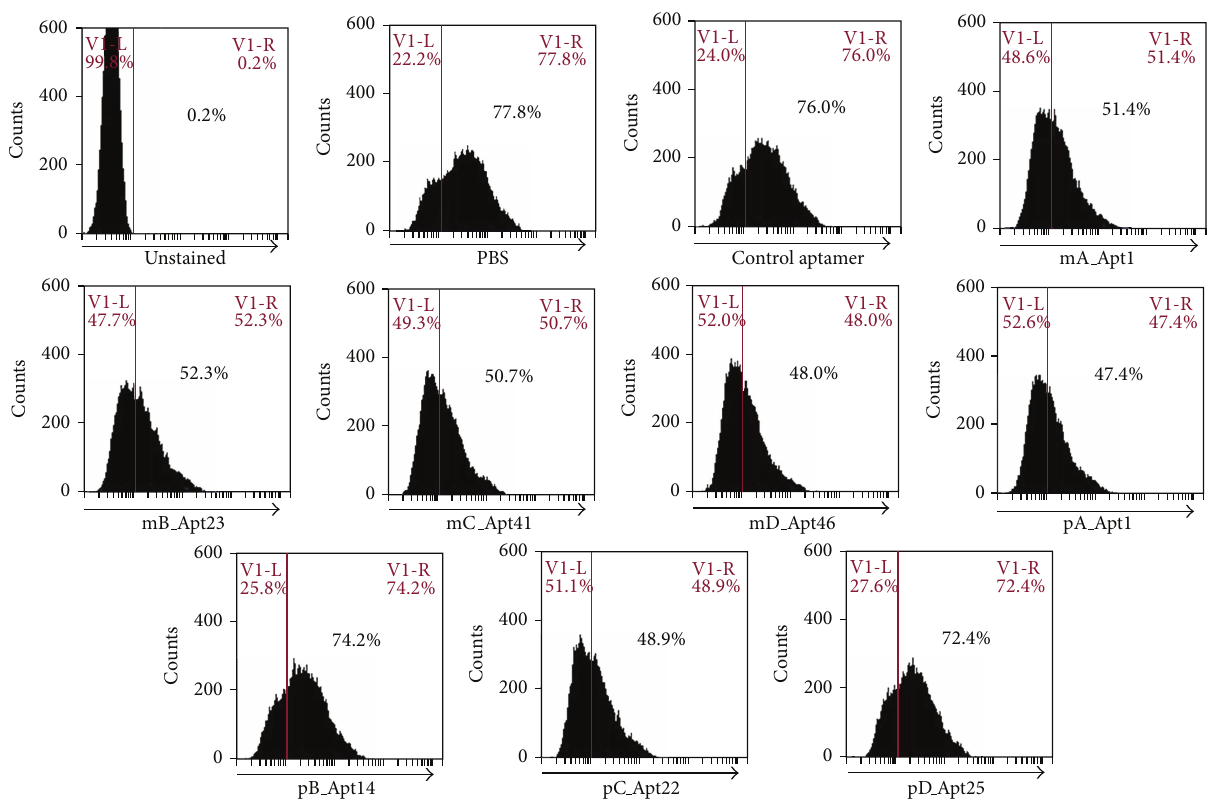
Figure 3: Flow cytometry analysis of HeLa cells treated with Stx2 and aptamers. Flow cytometry analysis showed that, in absence of any aptamer, Stx2-AF labeled ∼ 78% of the HeLa cells, and in presence of an unrelated control aptamer, Stx2-AF labeled 76% cells. Most of the Stx2-specific aptamers (mA Apt1, mB Apt23, mC Apt41, mD Apt46, pA Apt1, and pCApt22) inhibited Stx2 binding weakly as approximately 50% of HeLa cells were labeled in the presence of these aptamers. Similar to the unrelated control aptamer, the remaining 2 Stx2-binding aptamers (pB Apt14 and pD Apt25) did not inhibit Stx2 binding. This experiment was repeated twice with similar results.